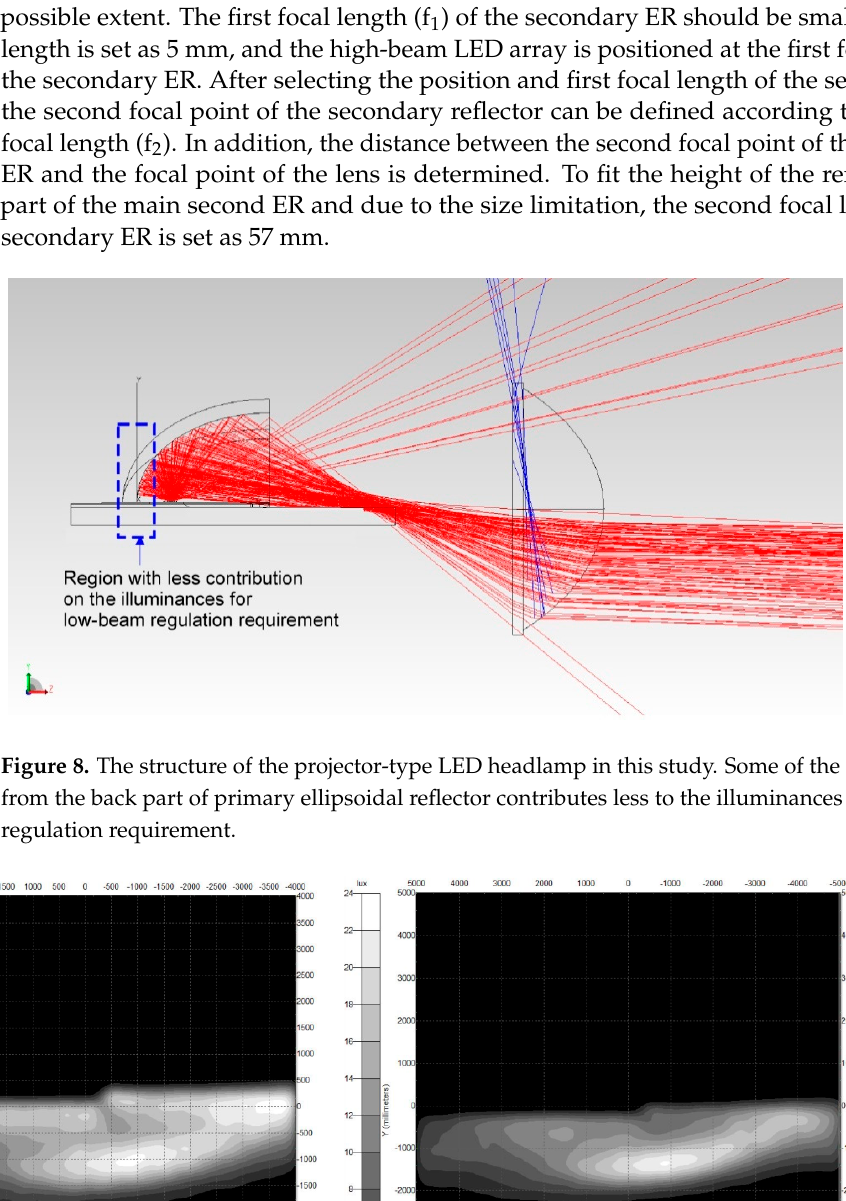
8 of 13 Figure 7. The low-beam headlamp with laterally expanding ellipsoidal reflector No. 1. 2.2. Design of the Secondary Ellipsoidal Reflector (Er) for High-Beam Light To obtain a single headlamp with both low- and high-beam light, a compound ER composed of two simple ERs is used. The secondary ER concentrates the light generated by the high-beam LED array device onto its second focal point. By using a baffle plate and primary ER, the light generated from the high-beam LED array device can be directed and transmitted through a specific condenser lens to illuminate the region for high-beam light. The compound ER comprises a primary ER and secondary ER. The front part of the com-